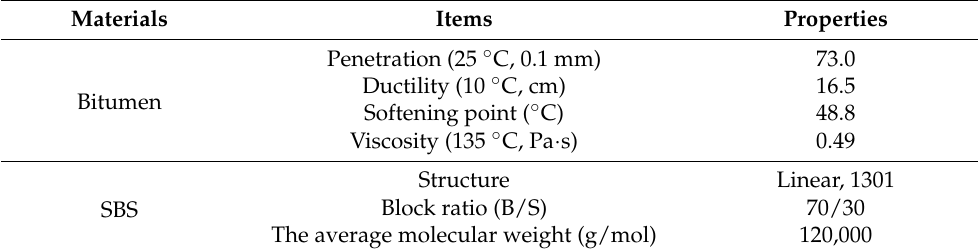
Table 1. The basic properties of virgin bitumen and SBS.